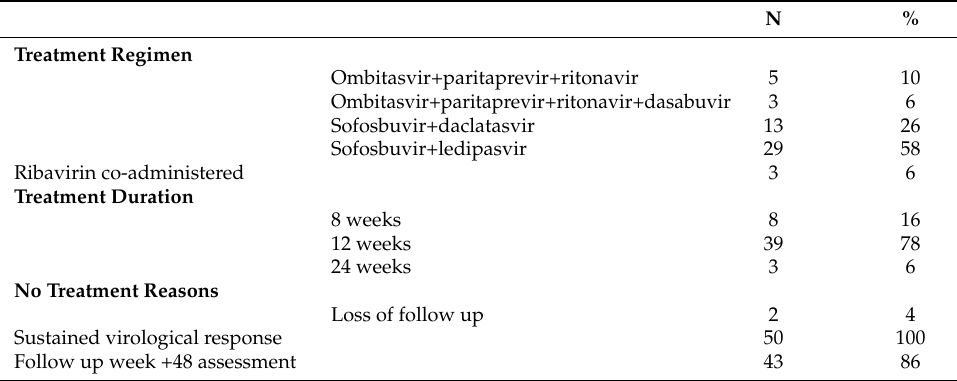
Table 1. Treatment